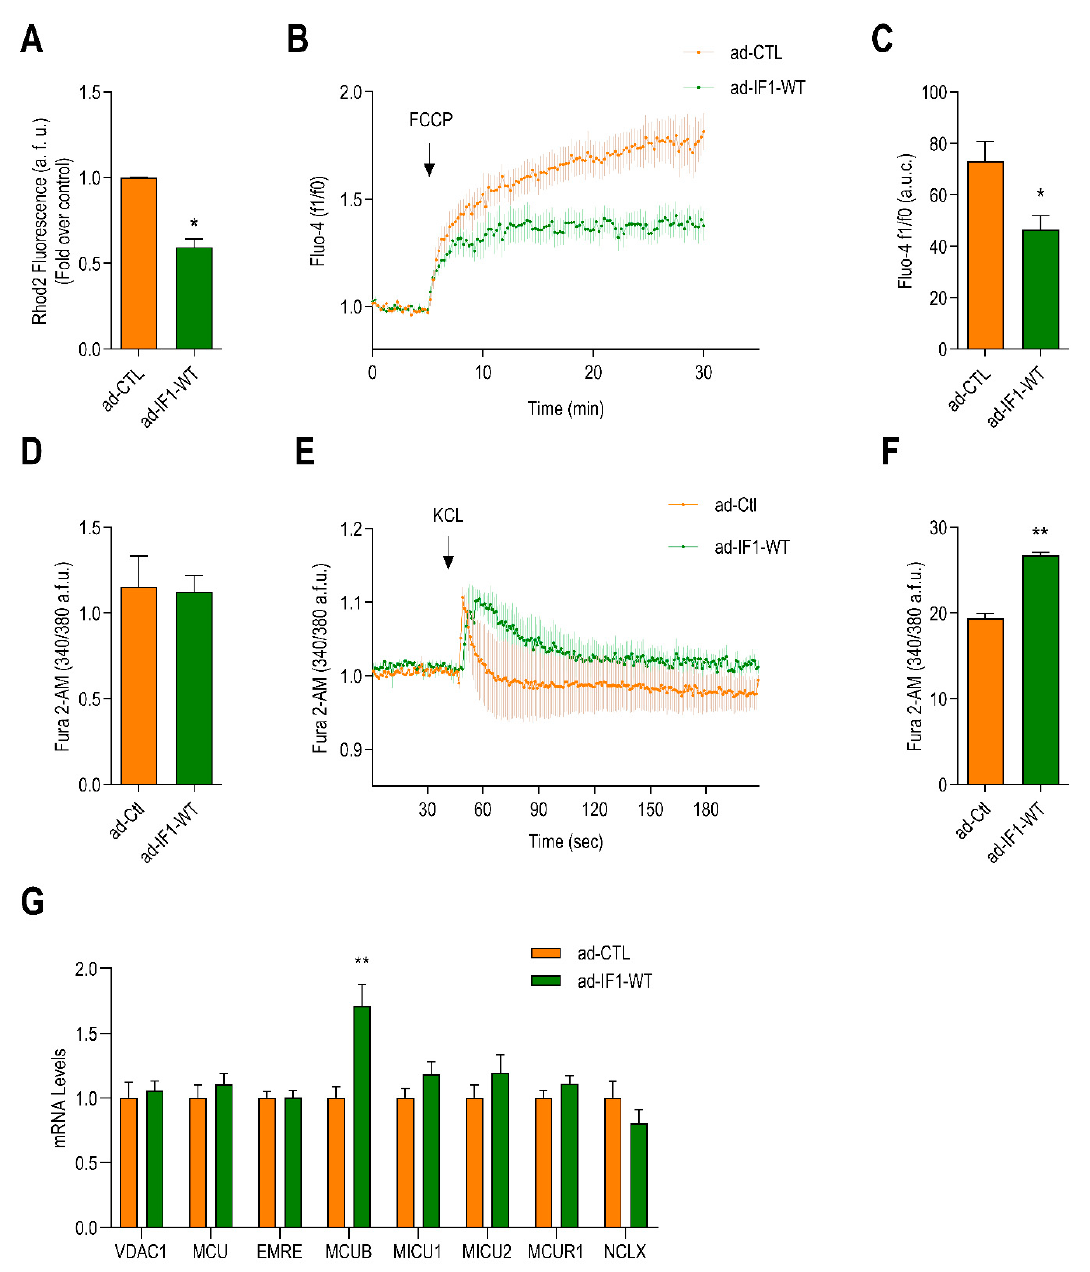
Figure 5. IF1 reduces mitochondrial calcium, promotes sarcoplasmic reticulum (SR) calcium overload, and activates calcium–calmodulin kinase II (CAMKII) signaling. NRVMs were infected with adenovirus ad-IF1-WT and ad-CTL for 48 h. ( A ) Bar graph depicting differences in basal mitochondrial Ca 2+ detected by with Rhod-2 AM ( n = 4). ( B ) Time lapse of mitochondrial Ca 2+ release measurements using Fluo-4 AM before and after addition of FCCP ( n = 5). ( C ) Differences in the area under the curve of Fluo-4 AM fluorescence after the addition of FCCP ( n = 5). ( D ) Cytosolic Ca 2+ measurements using Fura-2 AM in cells infected with ad-IF1-WT or ad-CTL using an epifluorescence microscope ( n = 4). ( E ) Representative experiment of potassium chloride (KCL)-induced sarcoplasmic reticulum (SR) Ca 2+ release ( n = 3). ( F ) Bar graph depicting differences in the area under the curve of Fura-2 AM 340/380 fluorescence ratio after the addition of KCL ( n = 3). ( G ) Bar graphs depicting mRNA levels of different calcium regulatory genes assessed by qPCR; voltage-dependent anion channel 1 ( VDAC1 ); mitochondrial calcium uniporter ( MCU ); essential MCU regulatory element ( EMRE ),; dominant-negative pore-forming subunit of the MCU ß ( MCUB ); mitochondrial calcium uptake protein 1 and 2 ( MICU1 and MICU2 respectively); MCU regulator 1 ( MCUR1 ); mitochondrial sodium calcium exchanger ( NCLX ), ( n = 4). Data are presented as mean ± SEM. * p < 0.05 and ** p < 0.01 vs. ad-CTL using the Mann–Whitney U -test or T -test where